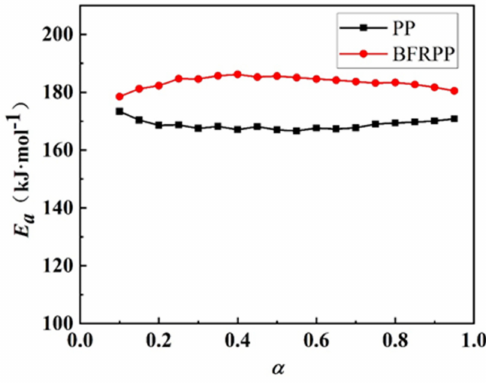
Figure 6. Comparison of activation energy of BFRPP and PP. Table 3. Apparent activation energy ( E a ) of BFRPP and PP obtained by Kissinger (cid:48) s